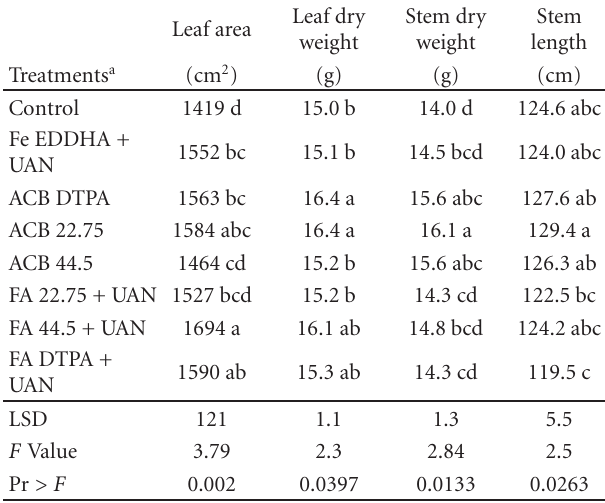
Table 3: Biomass results of OP-367 ( P. deltoides × P. nigra ) showing significant di ff erences after amending with industrial byproducts. Means with the same letter are not significantly di ff erent at the α = 0 . 05